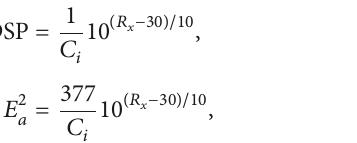
induced by the tablet at 1940 MHz for g